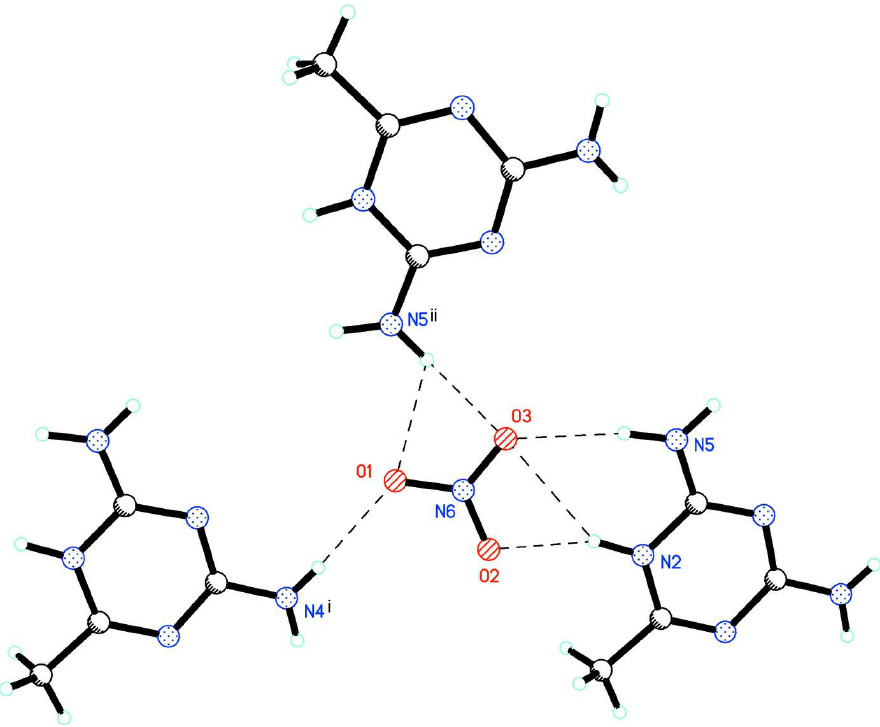
Figure 2 Perspective view of the hydrogen bonding interactions related to every nitrate anion where the hydrogen bonds are shown as dashed lines. [Symmetry codes: (i) x , y -1, z ; (ii) - x -1/2, y -1/2, - z